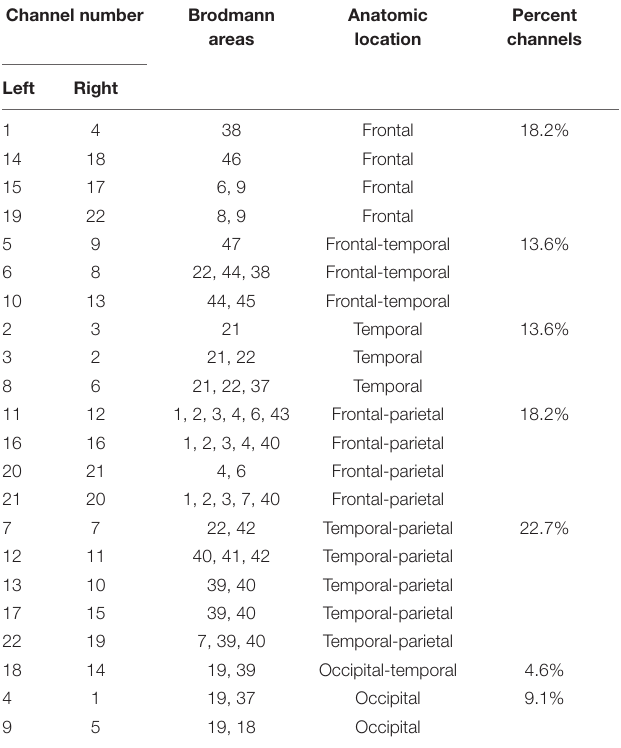
TABLE 2 | Corresponding Brodmann areas and cortical regions for each channel. Channel